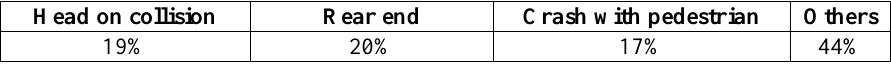
Table 21: Road accident deaths based on type of collision.